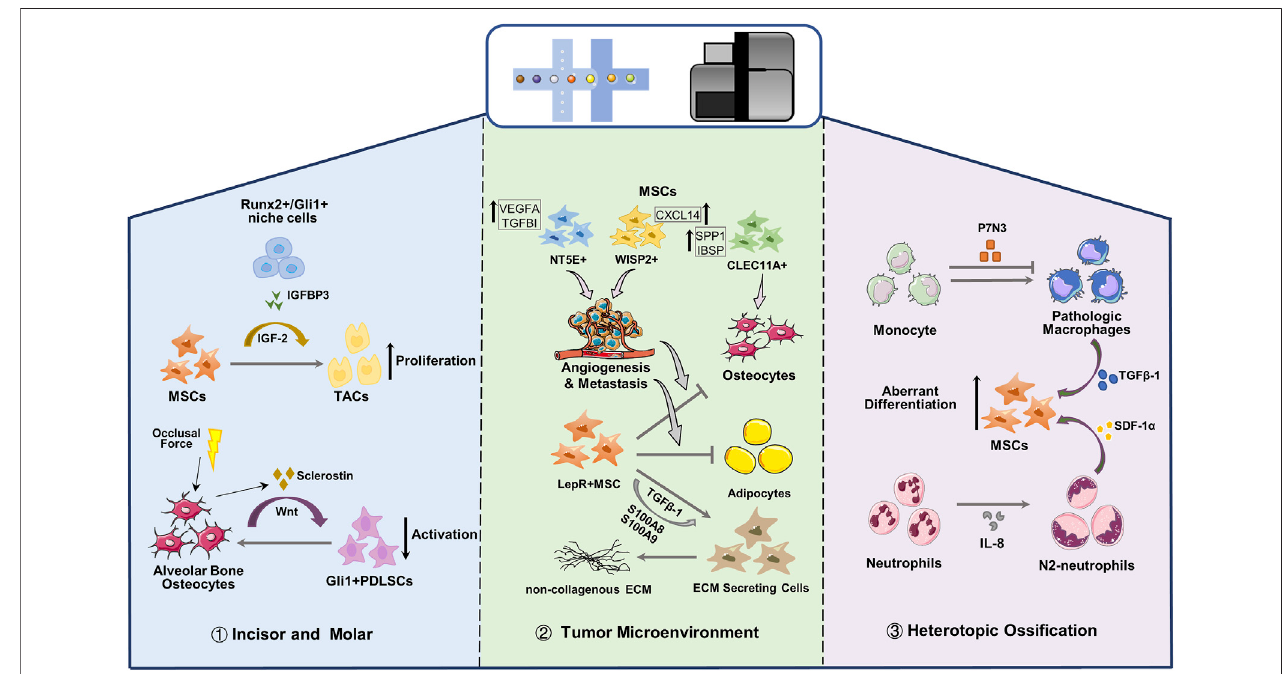
FIGURE 3 | Single cell reveals the crosstalk between MSCs and microenvironment. MSC, Mesenchymal stem cells; TAC, transit-amplifying cells; PDLSC, periodontal ligament stem cells; ECM, extracellular matrix.